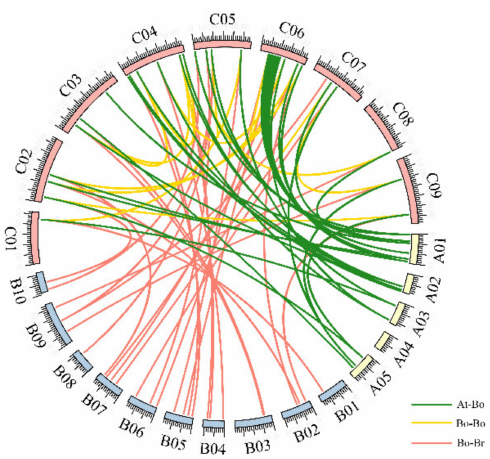
Figure 3. Syntenic relationship of SPL genes shown on chromosome maps among B. oleracea , B. rapa and A. thaliana